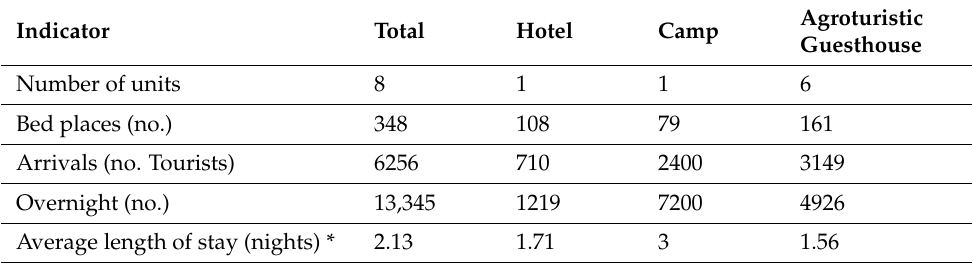
Table 1. Tourism supply indicators in 2018 in